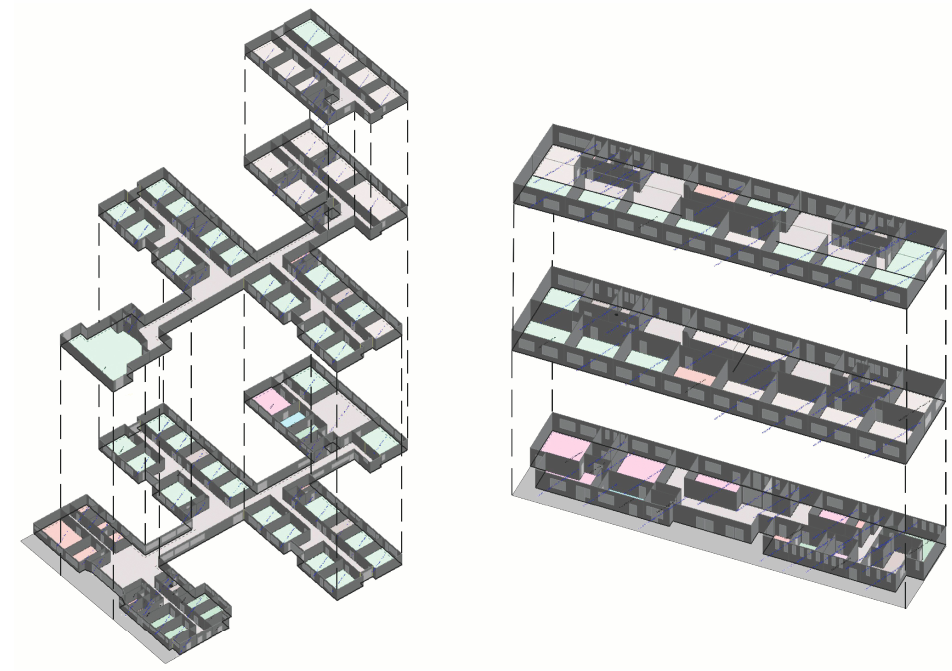
Figure 1. Design builder models for both Poliziano (on the left) and Rodari (on the right) school with the indication of the different thermal zones considered for the analysis.